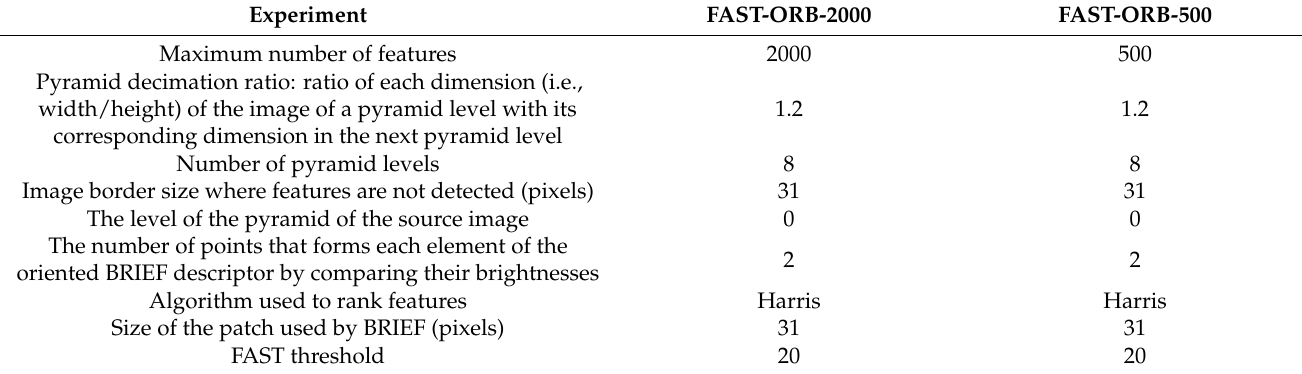
Table 5. Parameterization evaluated in the experiments performed using the oriented FAST detector and the ORB descriptor.